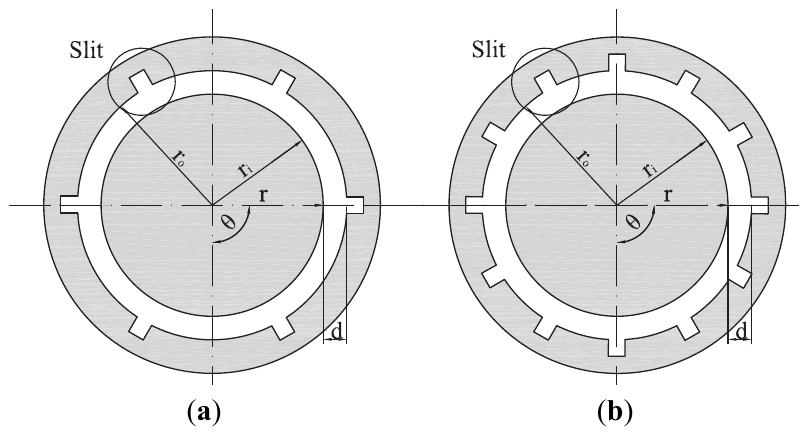
Figure 4. Geometries of calculation models: ( a ) 6-slit model; ( b ) 12-slit model.